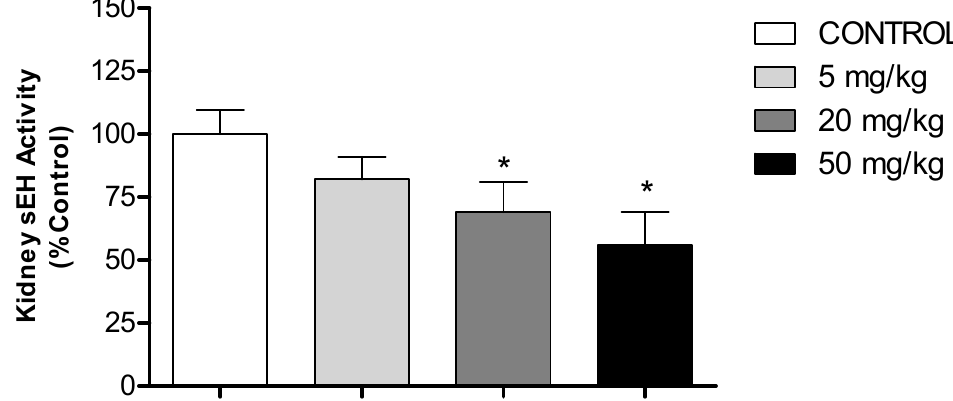
Figure 6. Effect of HON on the activity of kidney soluble epoxide hydrolase (sEH). Mean sEH activity from rat kidney cytosols ( n = 8/group) treated intraperitoneally daily for 3 weeks with HON at different concentrations. All groups were compared using one-way ANOVA followed by multiple comparisons. * Significant difference from control with p <